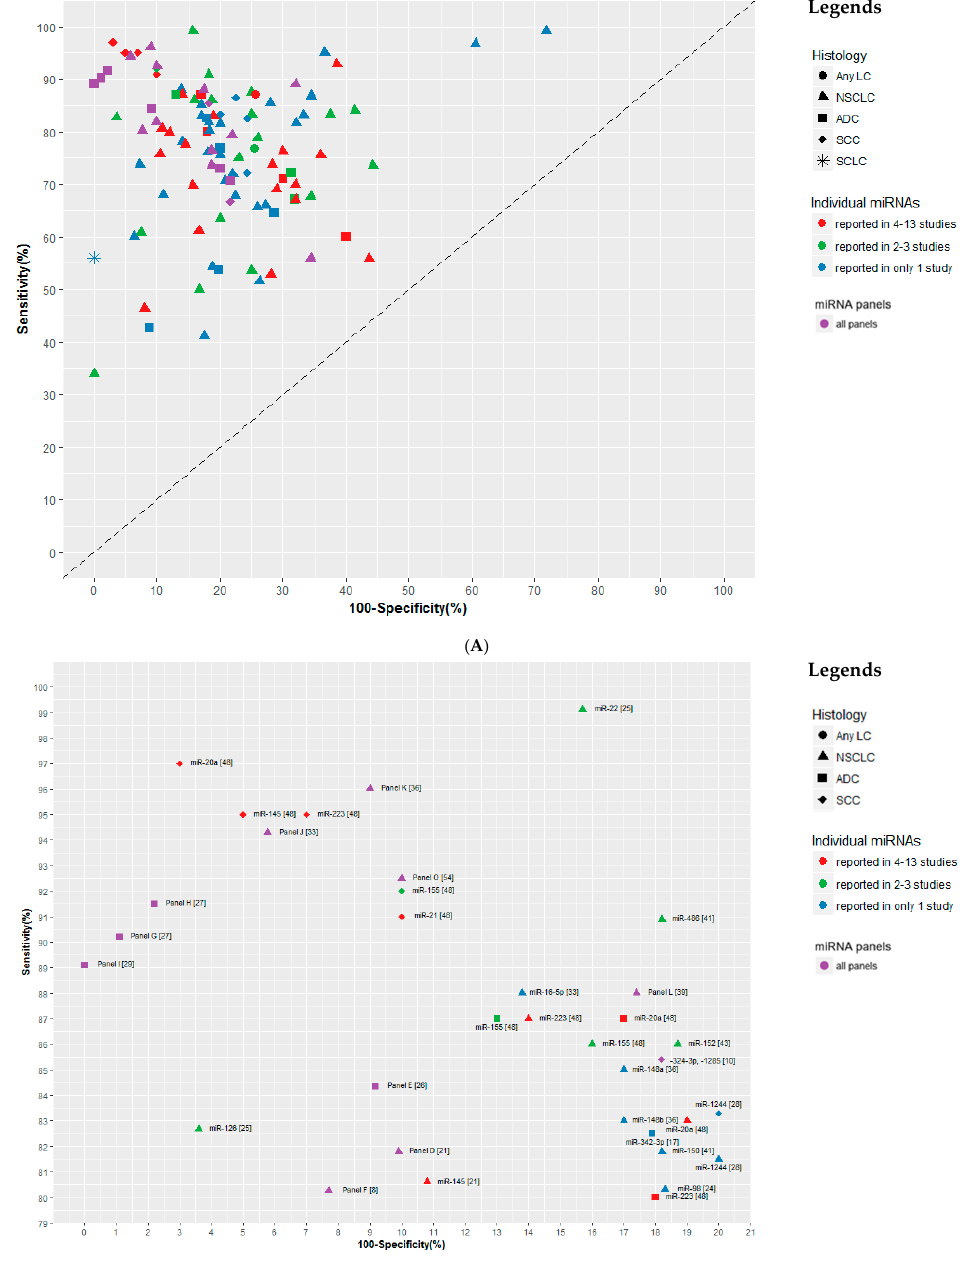
Figure 2. Graphical representation of sensitivity versus specificity of analyzed miRNAs. Sensitivity is plotted on the y-axis while on the x-axis the false positive rate is presented (100-Specificity). ( A ) Overview of all analyzed miRNAs and miRNA panels and ( B ) more detailed representation of miRNAs and miRNA panels with ≥ 80% sensitivity and ≥ 80% specificity. Panel D: -145, -20a, -21, -223; Panel E: -146a, -222, -223; Panel F: let-7b-5p, let-7e-5p, -24-5p, -21-5p; Panel G: -628-3p, -339-3p, -425-3p, -532; Panel H: -628-3p, -425-3p, -532; Panel I (20 miRs): -451, -1290. -636, -30c, -22-3p, -19b, -486-5p, -20b, -93, -34b, -185, -126-5p, -93-3p, -1274a, -142-5p, -628-5p, -486-3p, -425, -645, -24; Panel J: -20a-5p, -16-5p, -15b-5p; Panel K: -148a, -148b, -152, -21; Panel L: -25, -125a-5p, -126; Panel O (10 miRs): -20a, -24, -25, -145, -152, -199a-5p, -221, -222, -223, -320. Abbreviations: LC: lung cancer; NSCLC: non-small cell lung cancer; ADC: adenocarcinoma; SCC: squamous cell carcinoma; SCLC: small cell lung